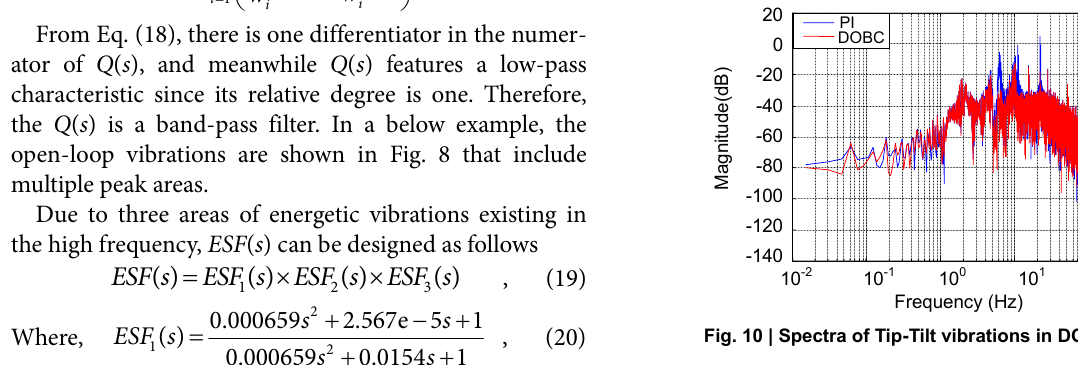
Fig. 9 | Bode response of Q ( s ) and ESF ( s ).